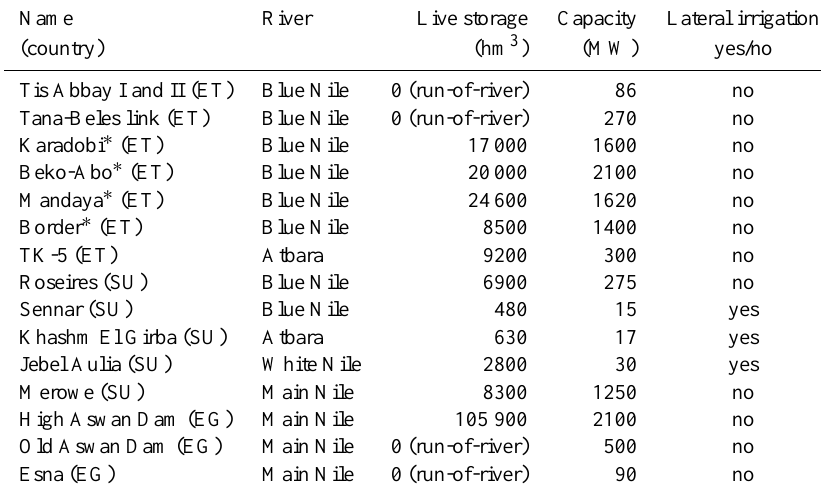
Table 1. Major infrastructures: hydropower plants and